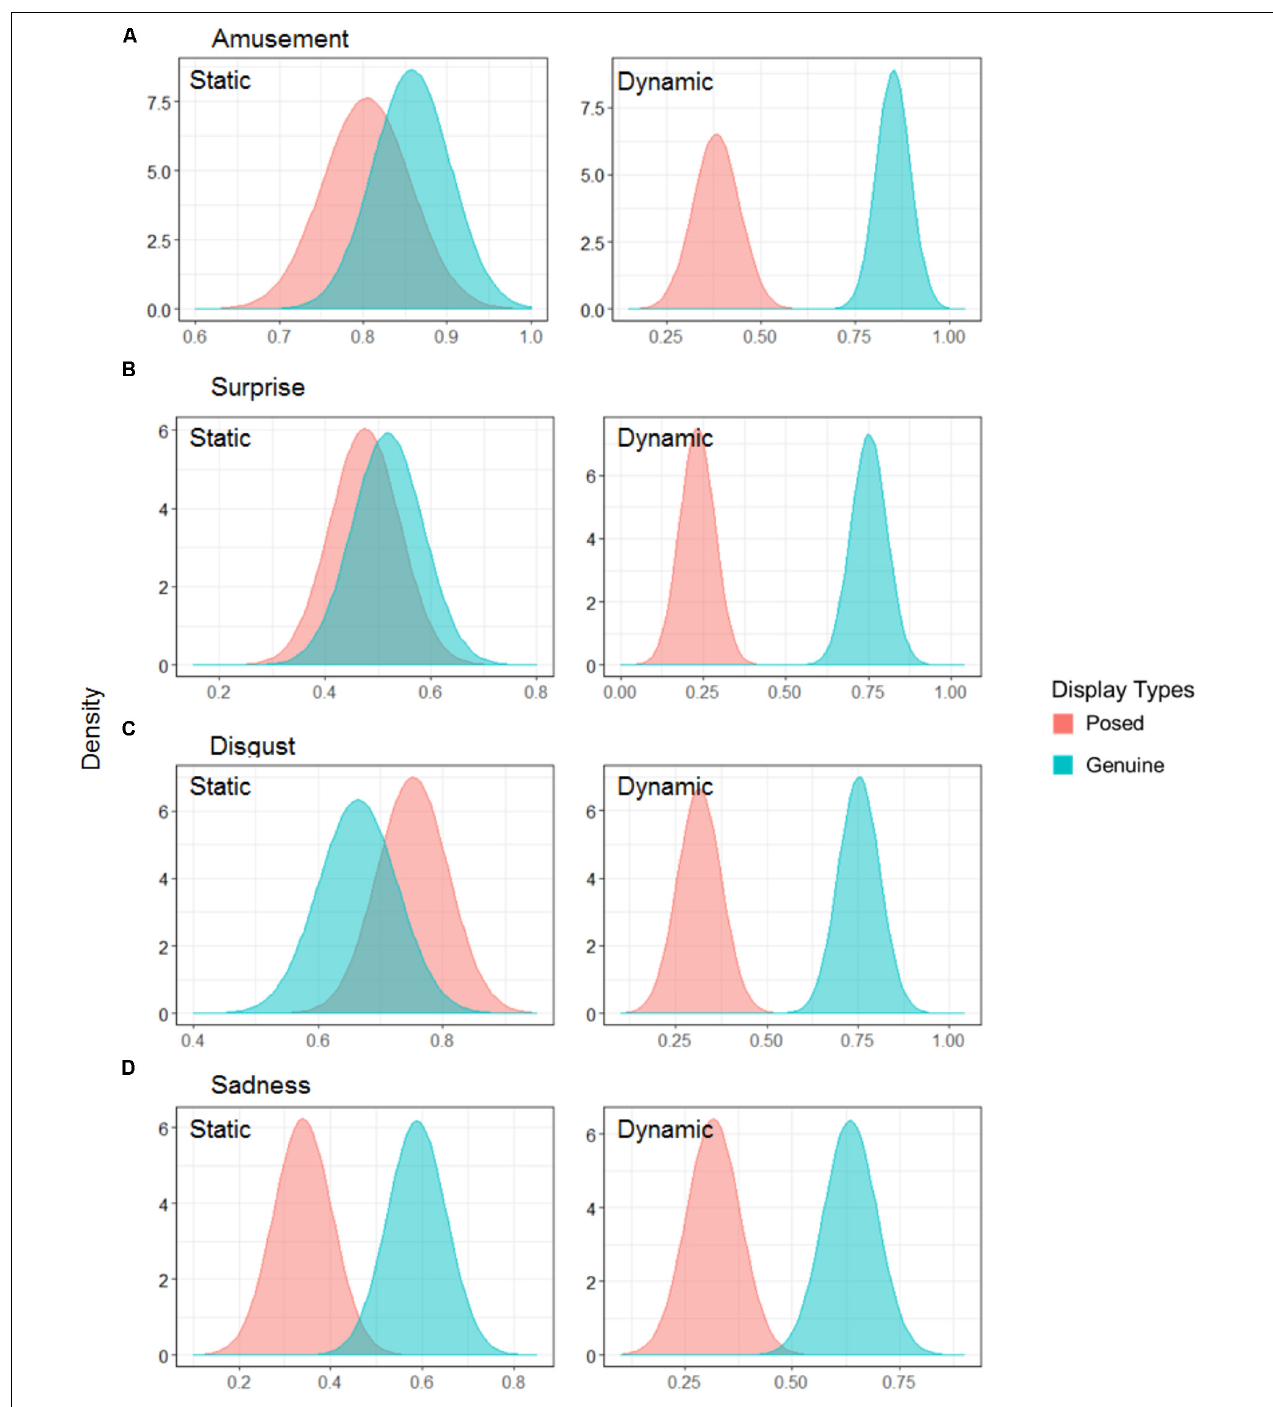
FIGURE 5 | The mean of the Yes response on the feel condition across each emotion. The distance between the two distributions can be interpreted as the discriminability of facial displays. Comparisons are shown for each specific emotion: (A) amusement, (B) surprise, (C) disgust, and (D) sadness.